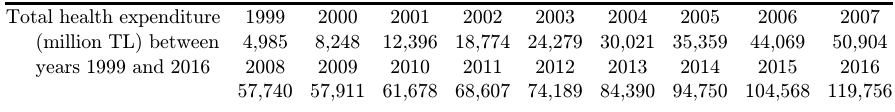
Table 1. Indicators on health expenditures, 1999 – 2016,